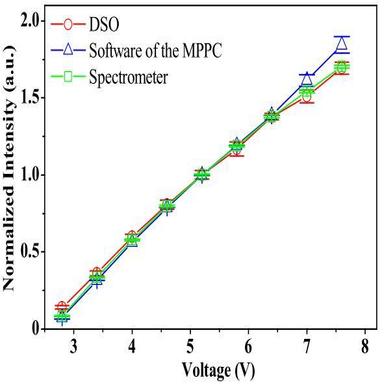
The normalized intensity of the average voltage (DSO), average photon number (Software of the MPPC) and count value (Spectrometer) to the median level (the fifth value) against the 9 discrete LED driver pulse amplitude values.